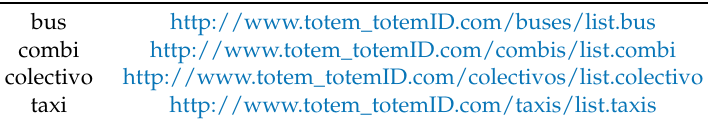
Table 4. URIs for